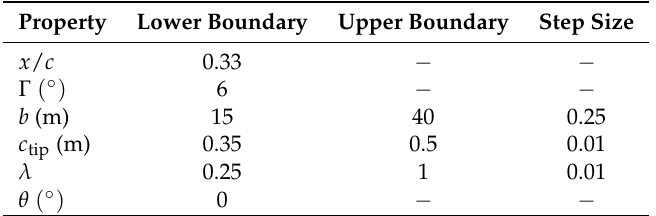
Table 3. Design of